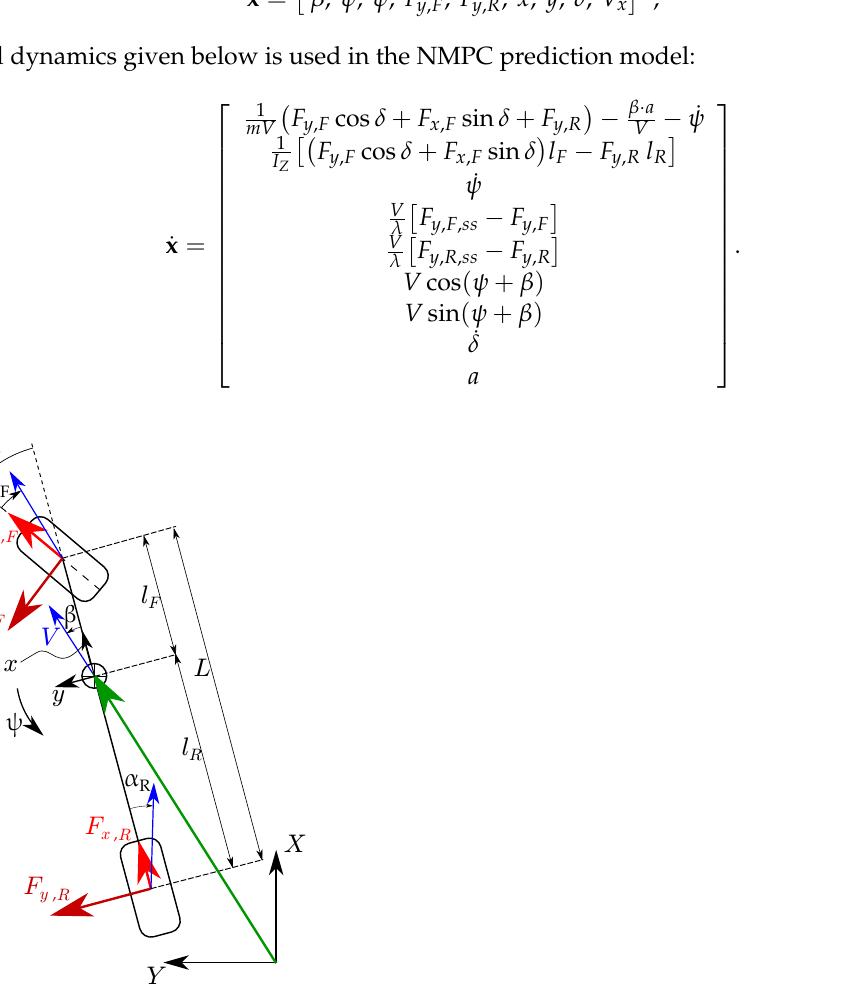
Figure 8. Single-track vehicle model. Reprinted with permission from Ref.